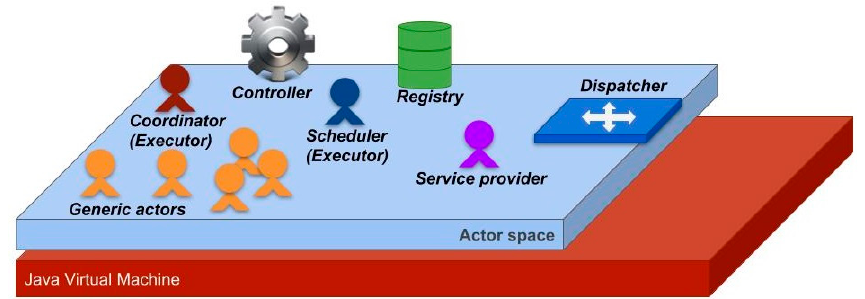
Figure 1. The actor space structure.